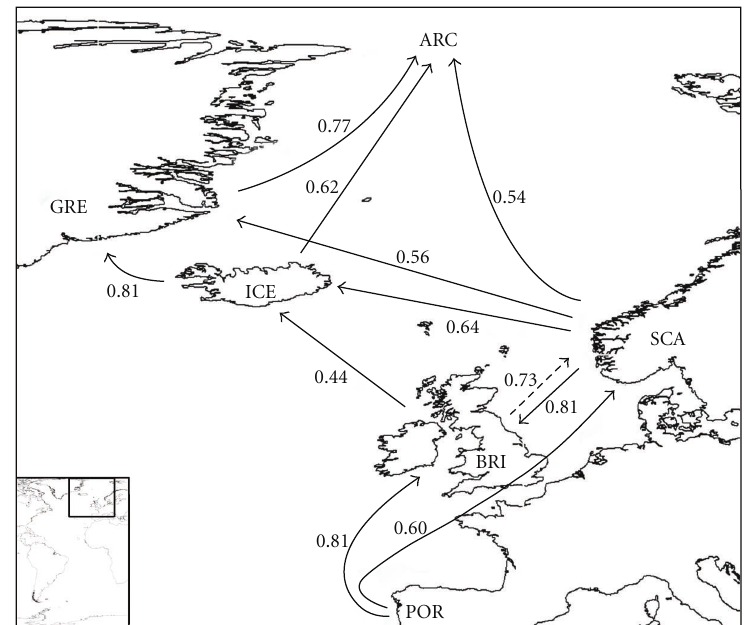
Figure 7: Probable colonization patterns of rissoid fauna in the Northeast Atlantic. The arrows represent the probable main flux direction of faunas, and the associated numbers represent, for each pair of areas, the higher of the two similarity index values computed as described in the methods, abbreviations as in Table 1.